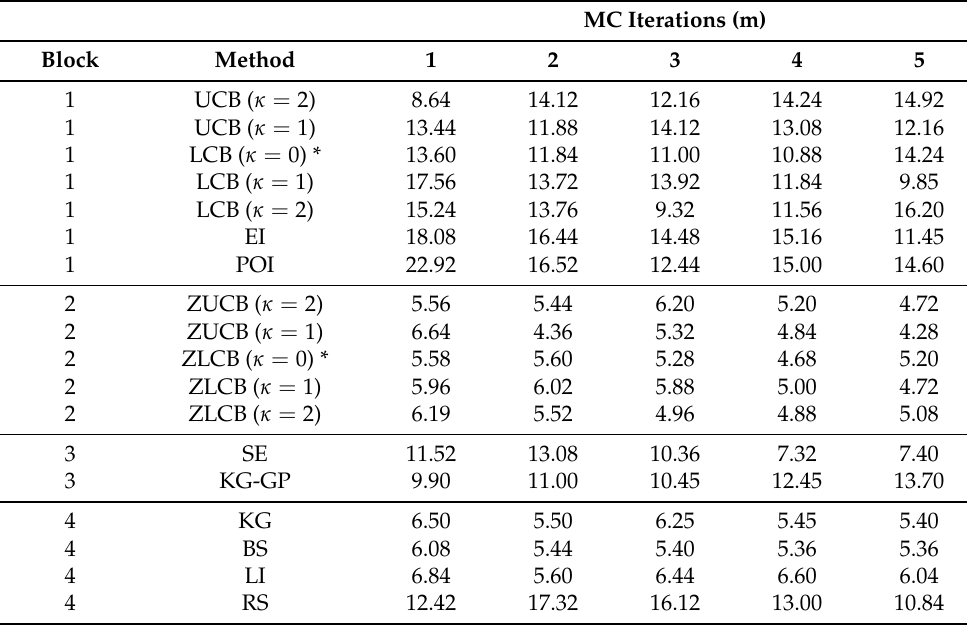
Table 2. Run number expected values, based on 25 runs in each case. * When κ = 0 the upper and lower CB methods are